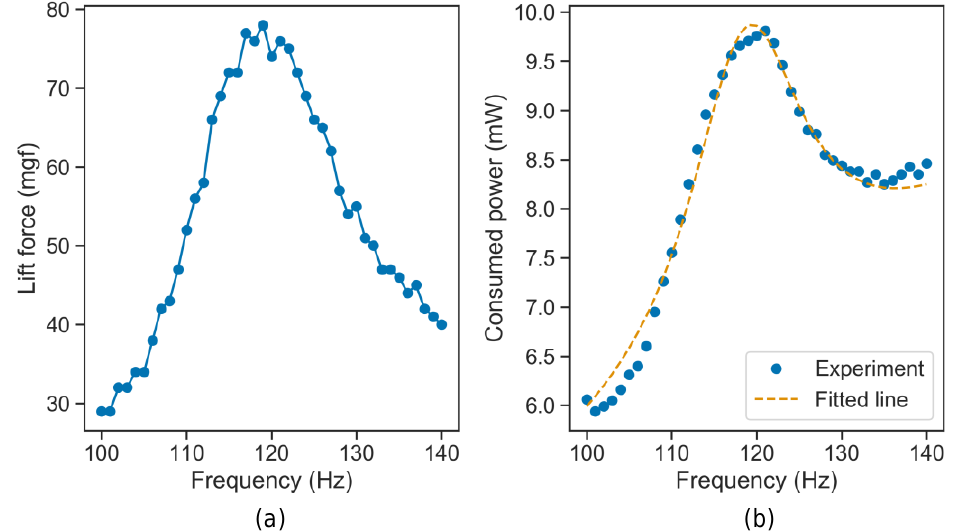
Figure A1. Frequency response of flapping wing actuator: ( a ) frequency-lift curve, ( b ) frequency–power curve with fitted line.